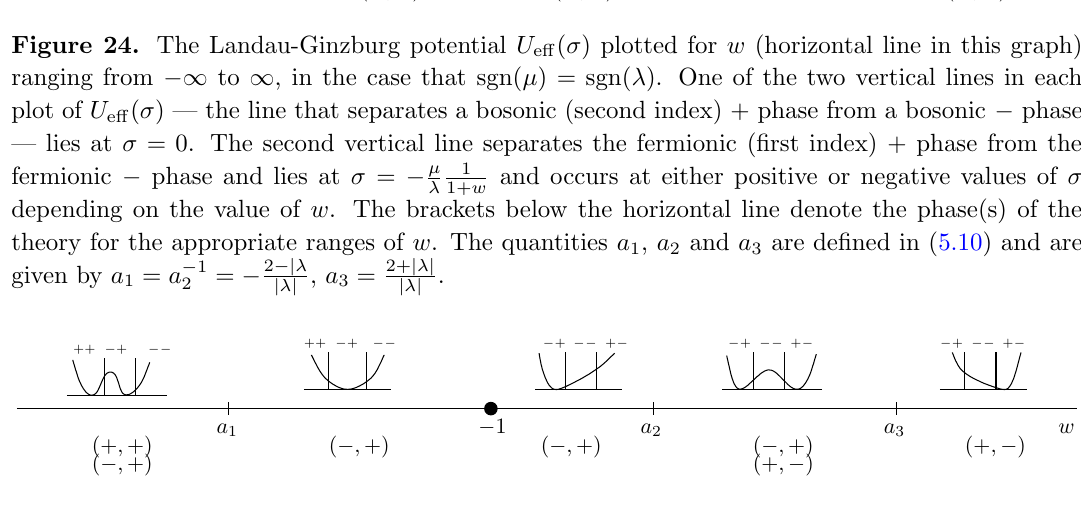
Figure 25. The Landau-Ginzburg potential U e(cid:11) ( (cid:27) ) plotted for values of the parameter w (hori- zontal line in this graph) ranging from (cid:0)1 to 1 in the case that sgn( (cid:22) ) = (cid:0) sgn( (cid:21) ). We follow the same notation as in (cid:12)gure